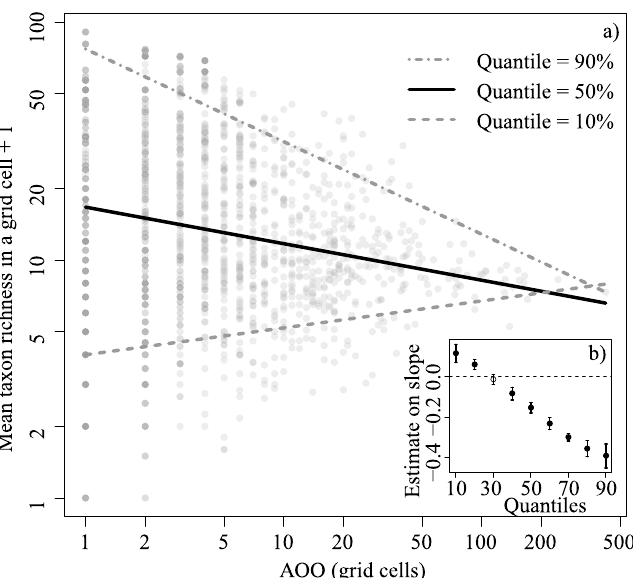
Figure 3. ( a ) Relationship between mean taxon richness in a grid cell and taxon AOO on Japanese threatened plants (empirical data). The black line denotes the predicted relationship based on 50th percentile regression, and grey dash, and dotted dash line denotes 10th and 90th percentile regression lines, respectively. ( b ) Change in the slope of the relationship along percentiles. Points and error bars indicate the estimate and 1.96 × Standard error. See also Supplementary Information 6 for estimates of the